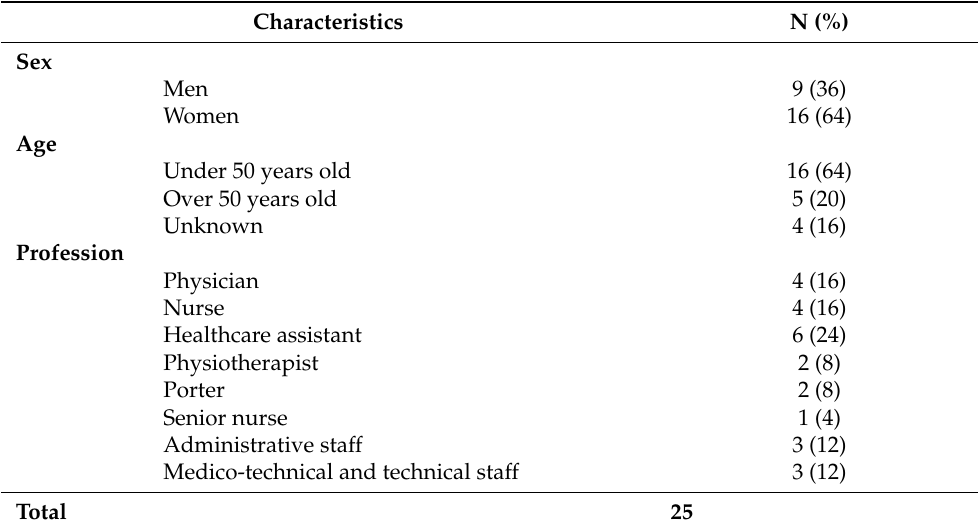
Table 2. Characteristics of participating health care workers, from January to April 2021, in Bordeaux University Hospital of France (N =